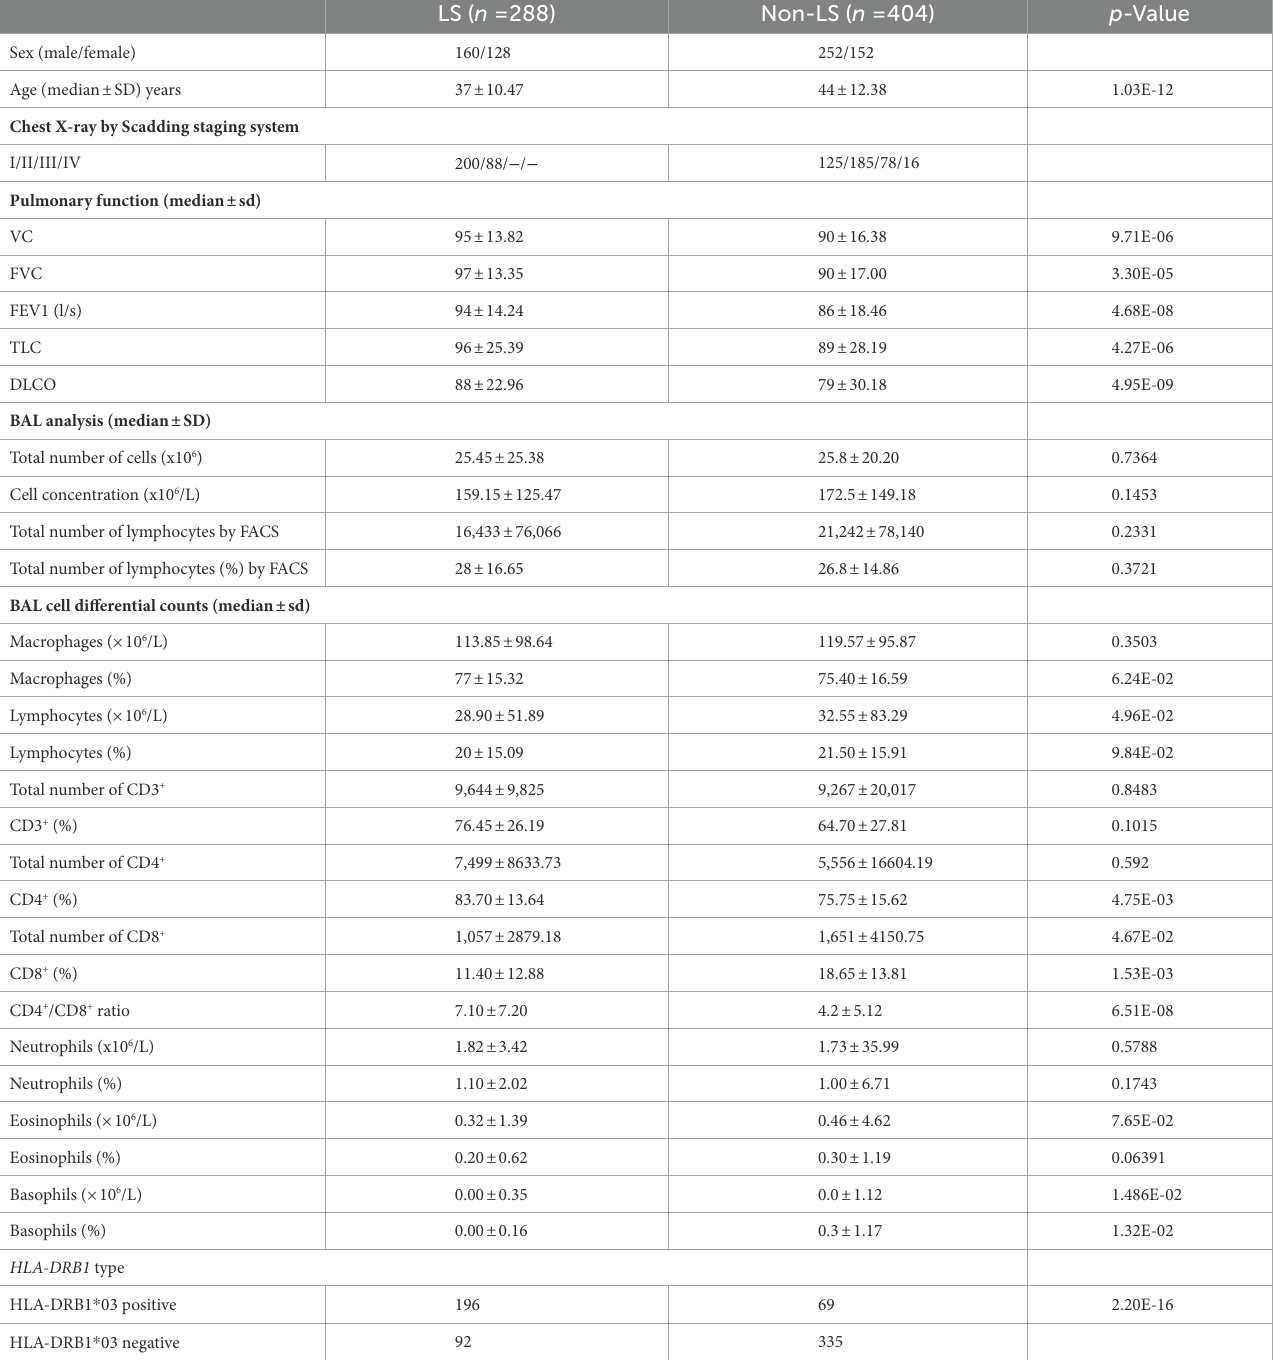
TABLE 1 Clinical and laboratory characteristics of studied Löfgren’s syndrome (LS) and non-Löfgren’s syndrome (non-LS) ( n =